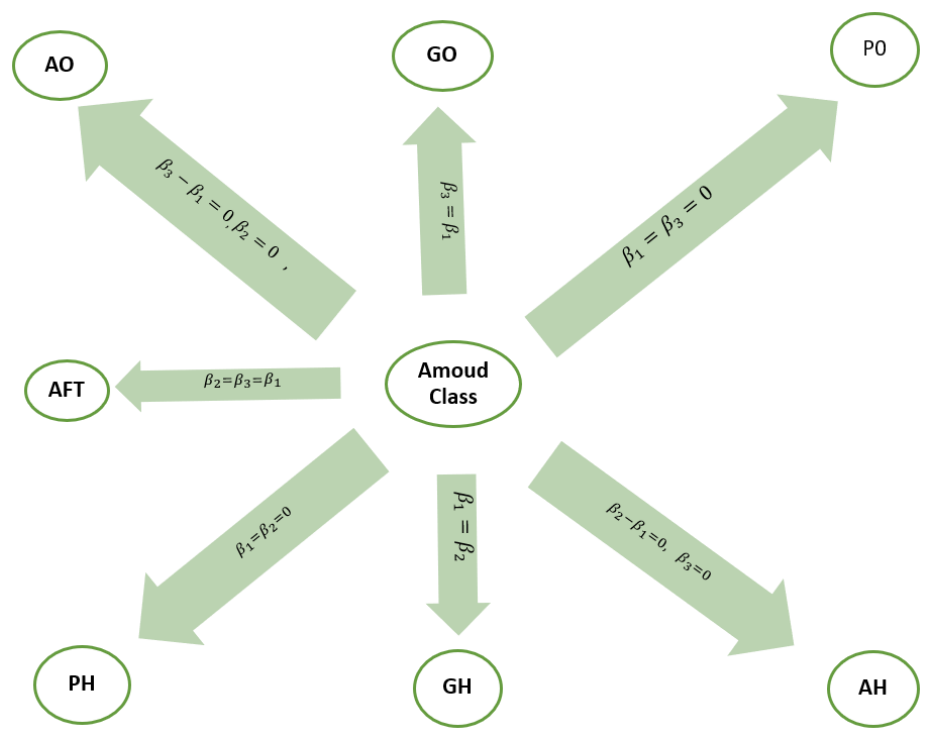
Figure 1. Visual graph illustrating the relationship between the proposed Amoud Class (AM) and its sub-models including the proportional hazard (PH), general odds (GO), general hazard (GH), accelerated failure time (AFT), accelerated odds (AO), accelerated hazard (AH), and proportional odds (PO)